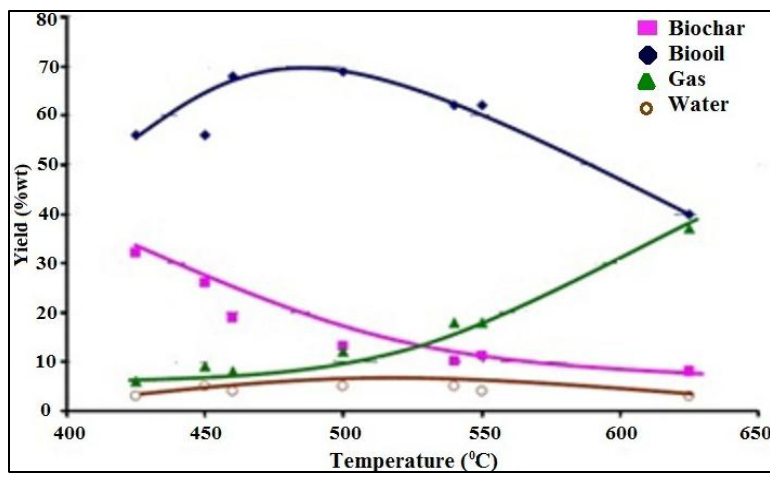
Figure 1. The % yield of the end products the pyrolysis of biomass [9].